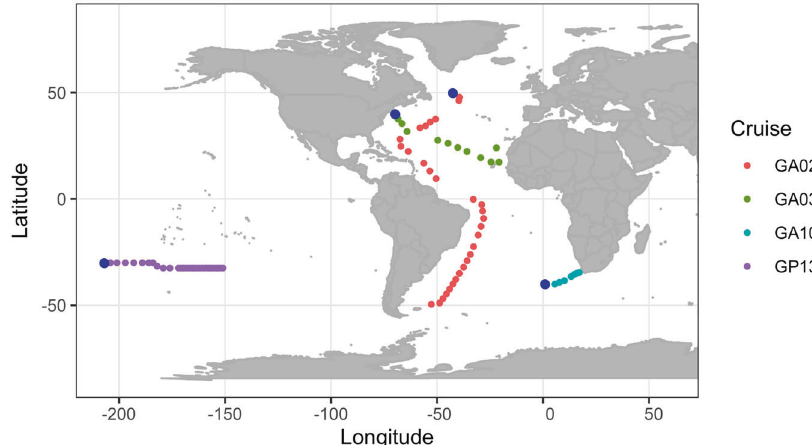
Fig. 1 Global map of sampling locations, colored by transect. Blue dots indicate the start of cruise